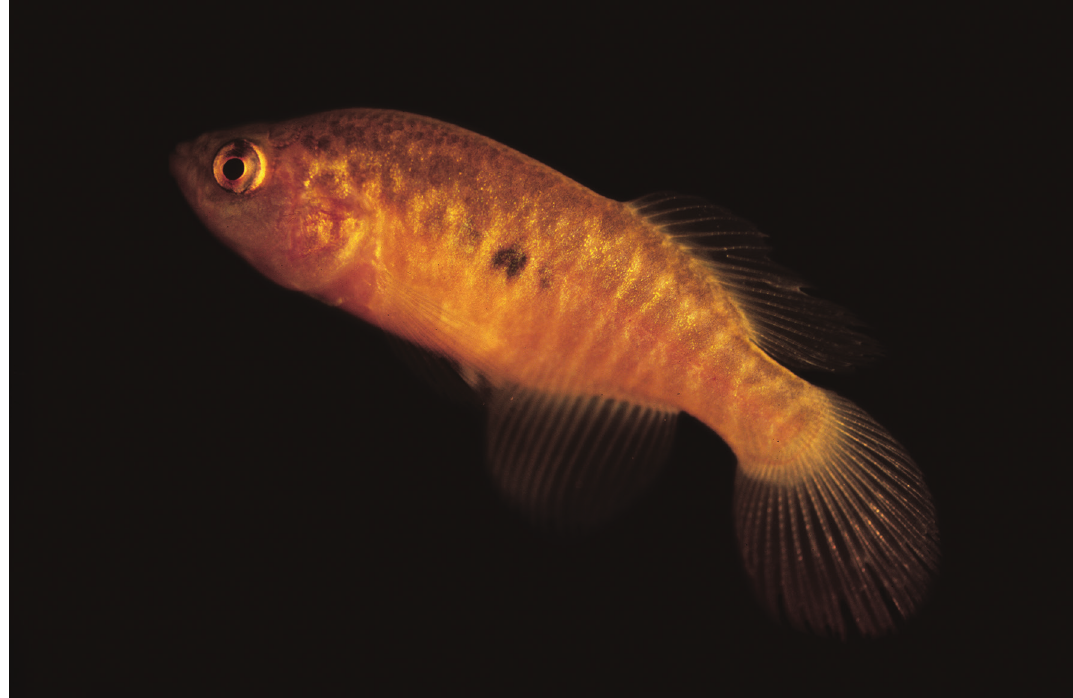
Figure 2. Cynolebias elegans sp. n., live paratype, UFRJ 9350, female, 35.1 mm SL. Photograph by W.J.E.M.